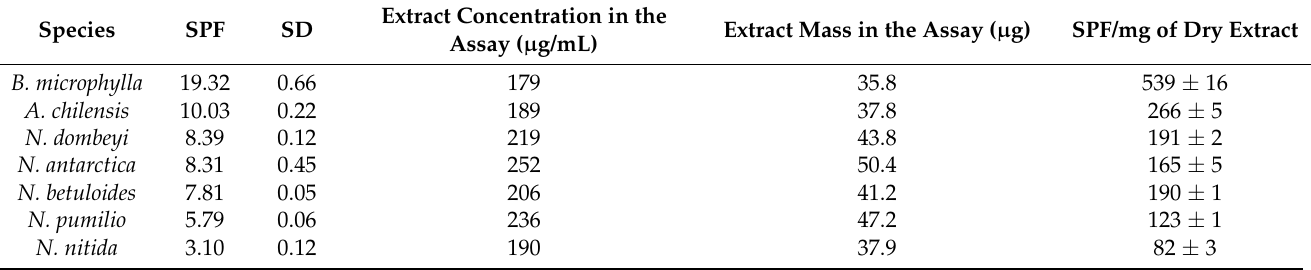
Table 2. Sun protection factor of the